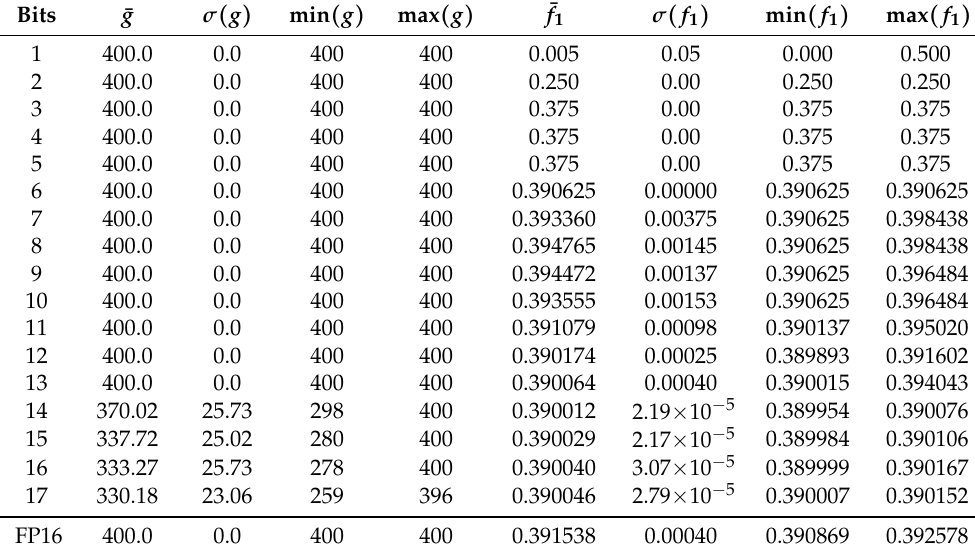
Table 4. Statistics of the 100 runs per bits used in the fractional part for the fixed point arithmetic and for the Rosenbrock function (14 bits were used for the integer part). Results for 100 runs for the FP16 are also shown. g represents the number of generations.